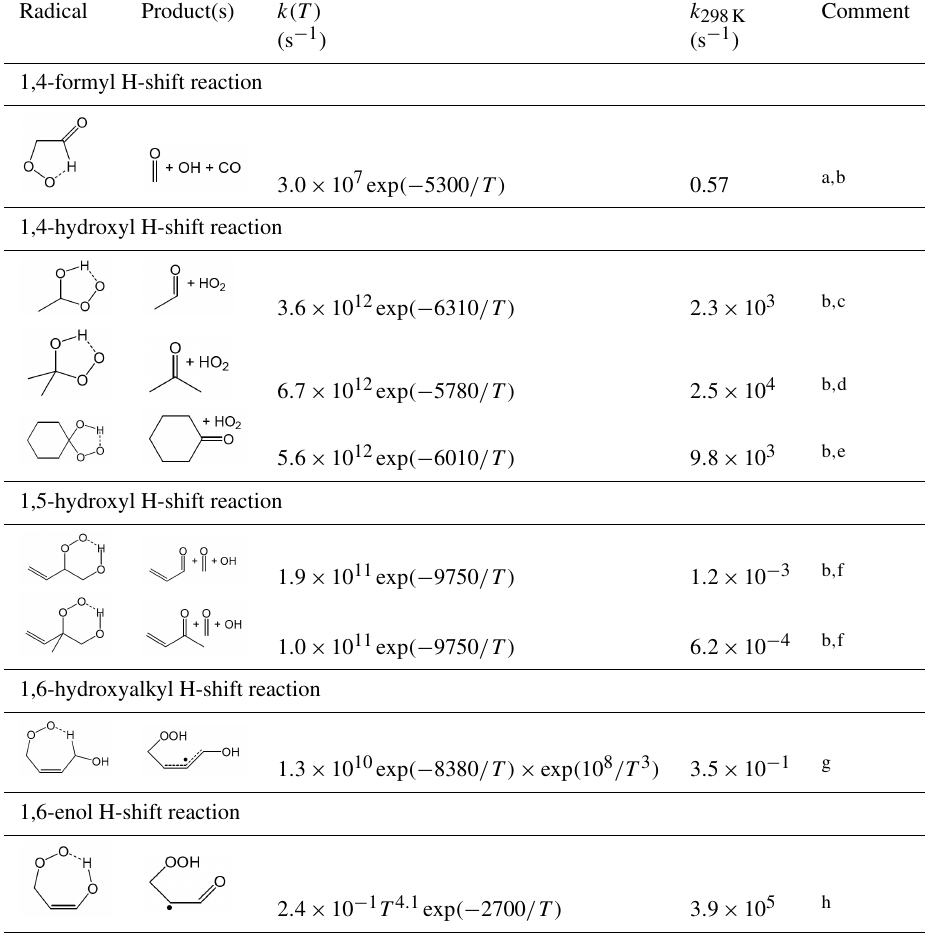
Table 15. Representative rate coefficients for selected H-shift isomerization reactions of peroxy